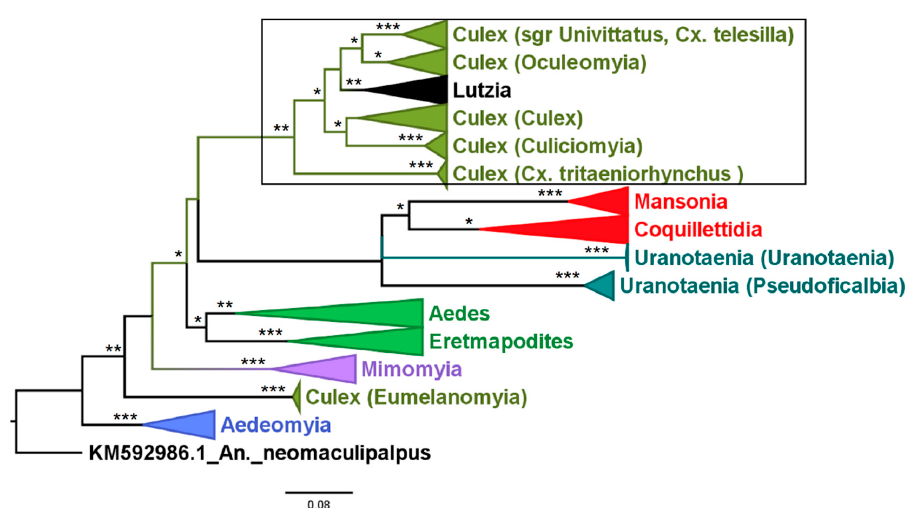
Figure 14. Phylogenetic analysis of 179 partial coxI nucleotide sequences from mosquitoes of the genera Aedeomyia , Aedes , Coquillettidia , Culex , Lutzia , Mimomyia , and Uranotaenia . At specific branches, the number of * indicates the tree topological support revealed by the different phylogenetic reconstruction methods, assuming relevant bootstrap and aLRT values above 75% and posterior probability values above 0.80. The collapsed branches indicate the different genera; “sgr” indicates the subgroup.